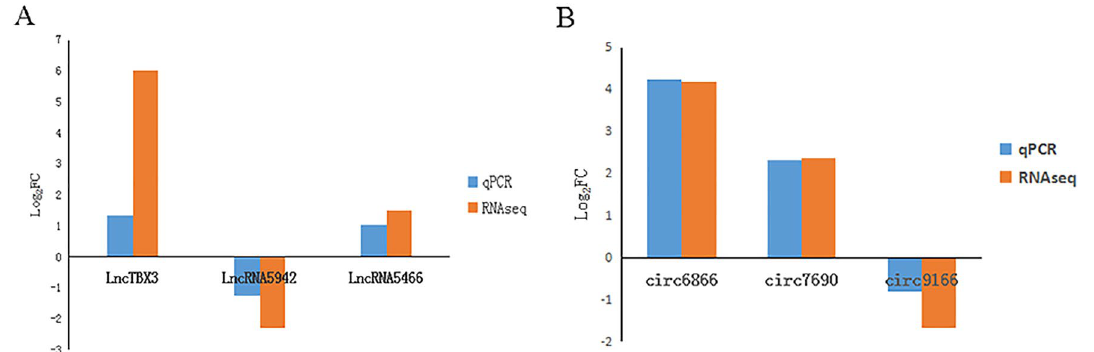
Figure 9. Using qRT–PCR to validate RNA-seq data. ( A ) RNA-seq and qRT–PCR data of the expression levels of lncRNAs, n = 3. ( B ) RNA-seq and qRT–PCR data of the expression levels of circRNAs, n =